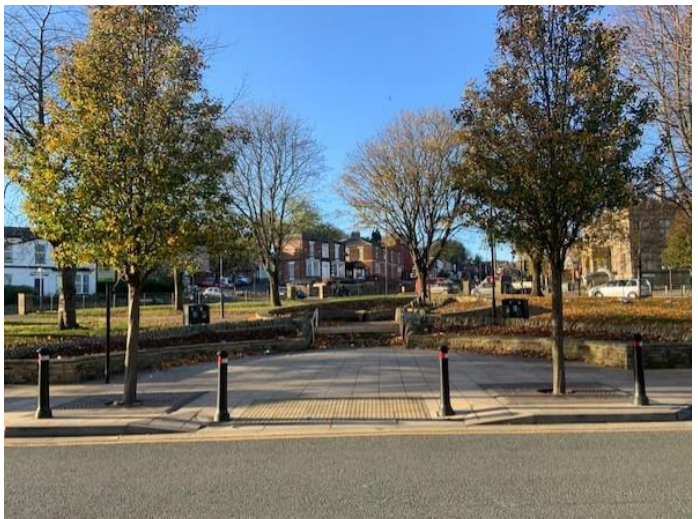
Figure 2. The Ellesmere Green © Authors